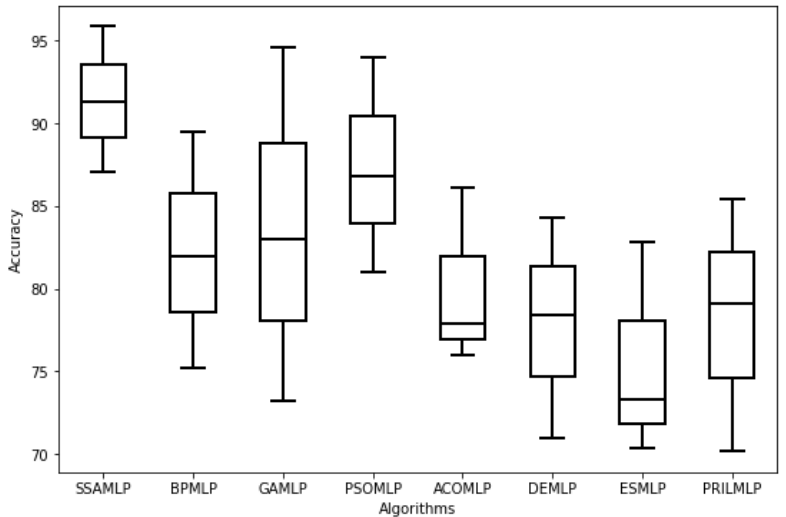
Figure 5. Boxplot representation for the proposed SSAMLP and other algorithms in terms of classifi- cation